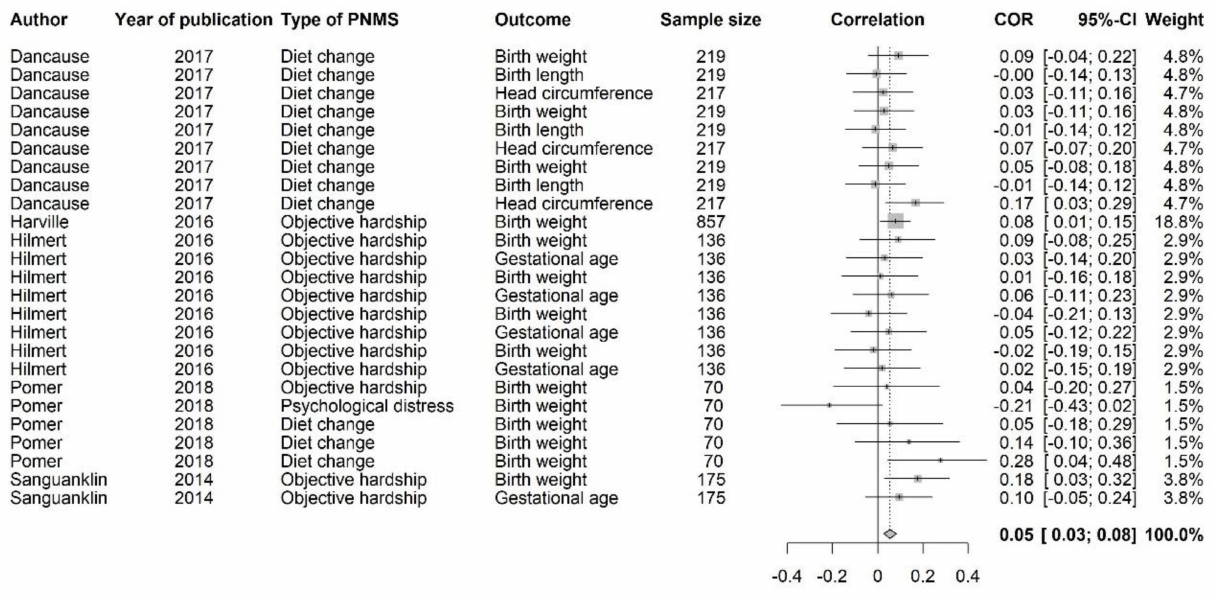
Figure 2. Birth Outcomes Forest